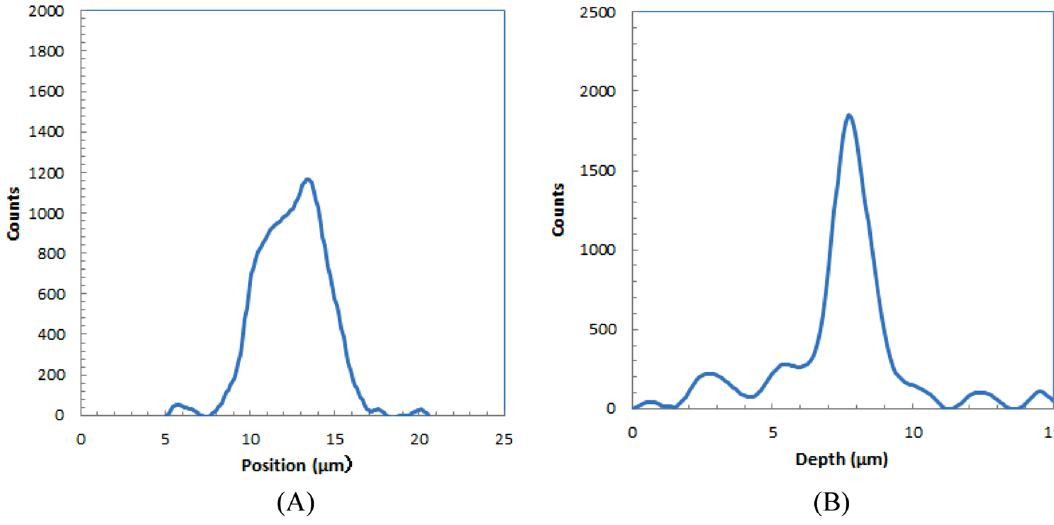
Figure 5. Depth ( A ) and lateral ( B ) profiles of alpha-particle trajectory for low-energy alpha source.